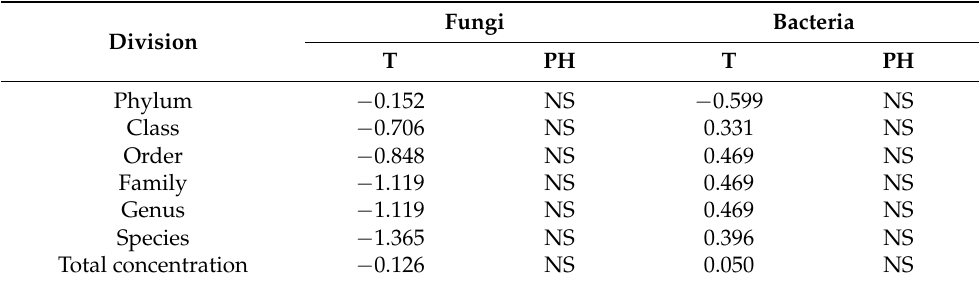
Table 8. Results of statistical analyses according to the type of drainage. Fungi Division